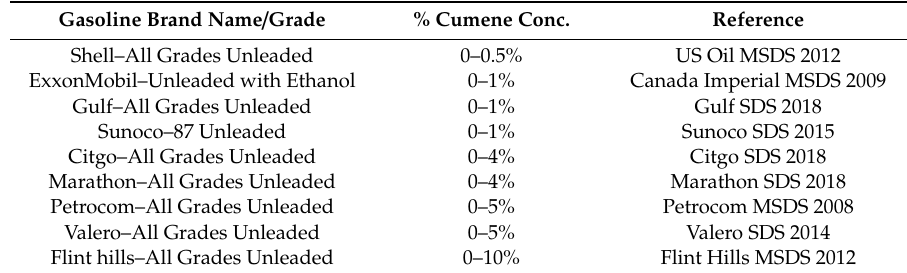
Table 1. Cumene concentration ranges reported by various fuel suppliers Material Safety Data Sheet / Safety Data Sheet (MSDS / SDS) [23–30].